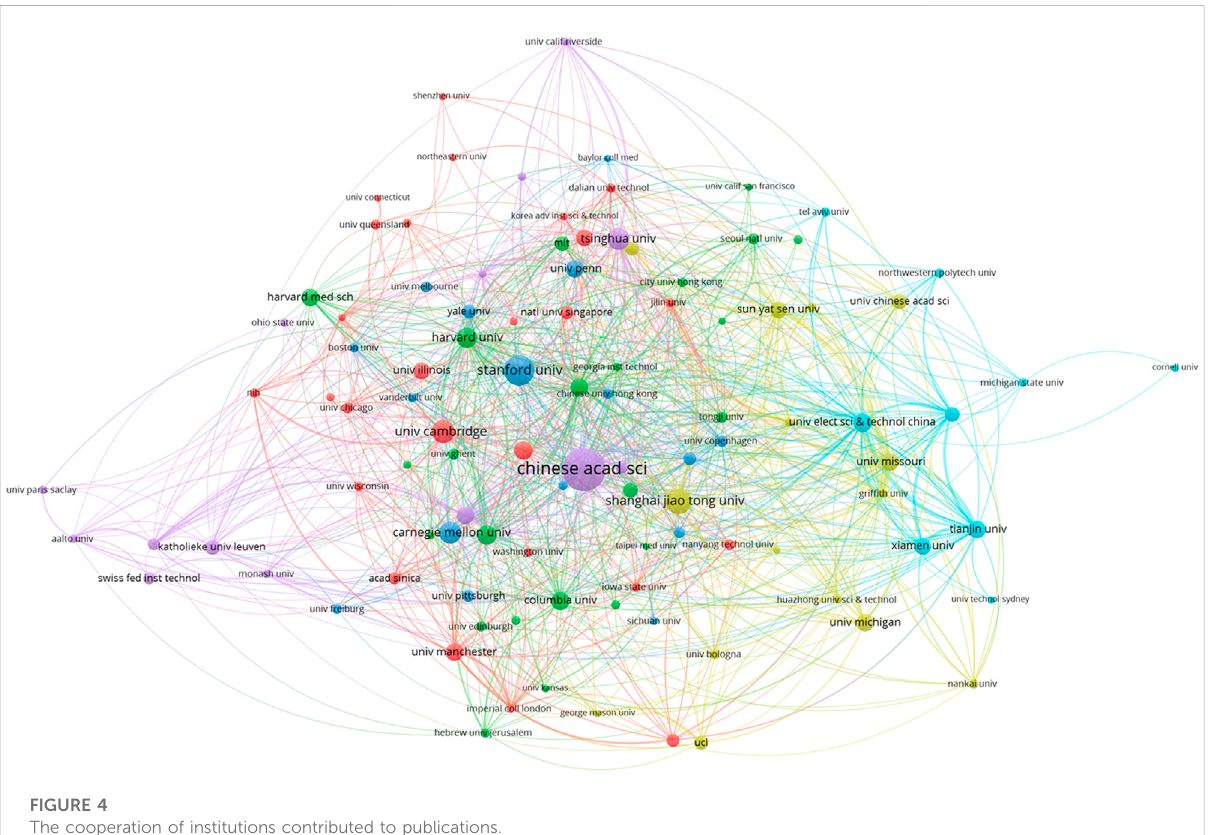
FIGURE 4 The cooperation of institutions contributed to publications.